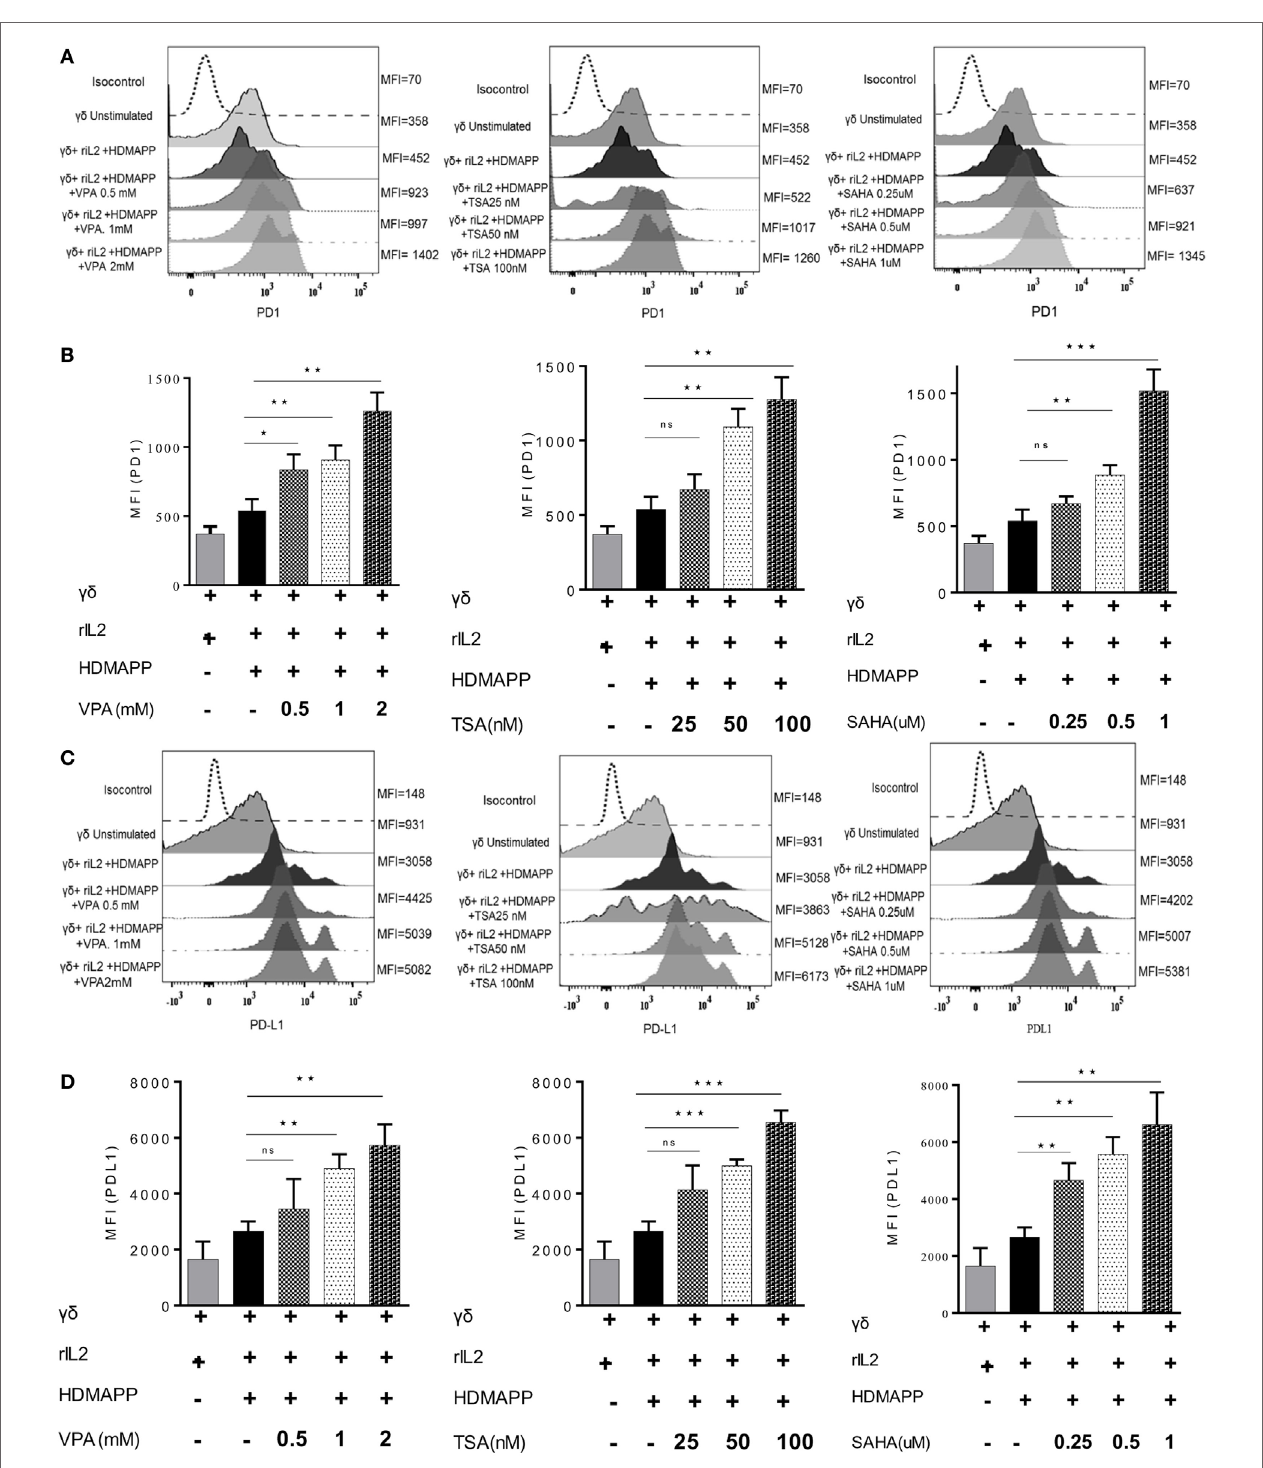
FigUre 7 | Histone deacetylases (HDAC) inhibitors upregulate the expression of immune checkpoints on γδ T cells. (a) The expression of programmed death-1 by HDAC inhibitor-treated γδ T cells at their respective concentration. Histograms are representative of three individual experiments. The values on right side of histograms indicate median fluorescence intensity (MFI) of PD1. (B) MFI of PD1 expression as bar graphs where * p < 0.05, ** p < 0.005, *** p < 0.0005 and ns, not significant when compared with γδ T cells activated with HDMAPP in the presence of rIL-2. (c) The expression of programmed death ligand-1 (PD-L1) by γδ T cells treated with HDAC inhibitors sodium valproate, Trichostatin-A, and suberoylanilidehydroxamic acid at their respective concentration was analyzed by immunostaining. Histograms shown are representative of three individual experiments. The values on right side of histograms indicate MFI of PD-L1. The results indicated in (D) are MFI of PD-L1 expression where * p < 0.05, ** p < 0.005, *** p < 0.0005 and ns, not significant when compared with γδ T cells activated with HDMAPP.